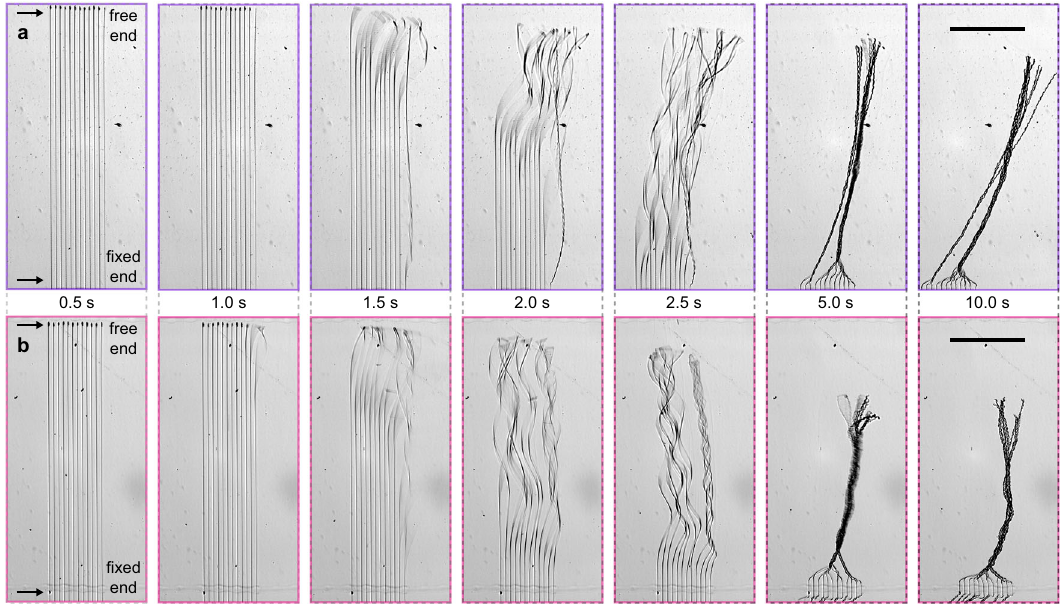
Fig. 4 | Bundling kinetics. Samples of aligned MSPs with d =60 μ m and ϕ =( a ) 26° or ( b ) 44°. Micrographs show each sample at 0.5, 1.0, 1.5, 2.0, 2.5, 5.0 and 10.0 s after introduction of pH 8 buffer solution. Scale bars